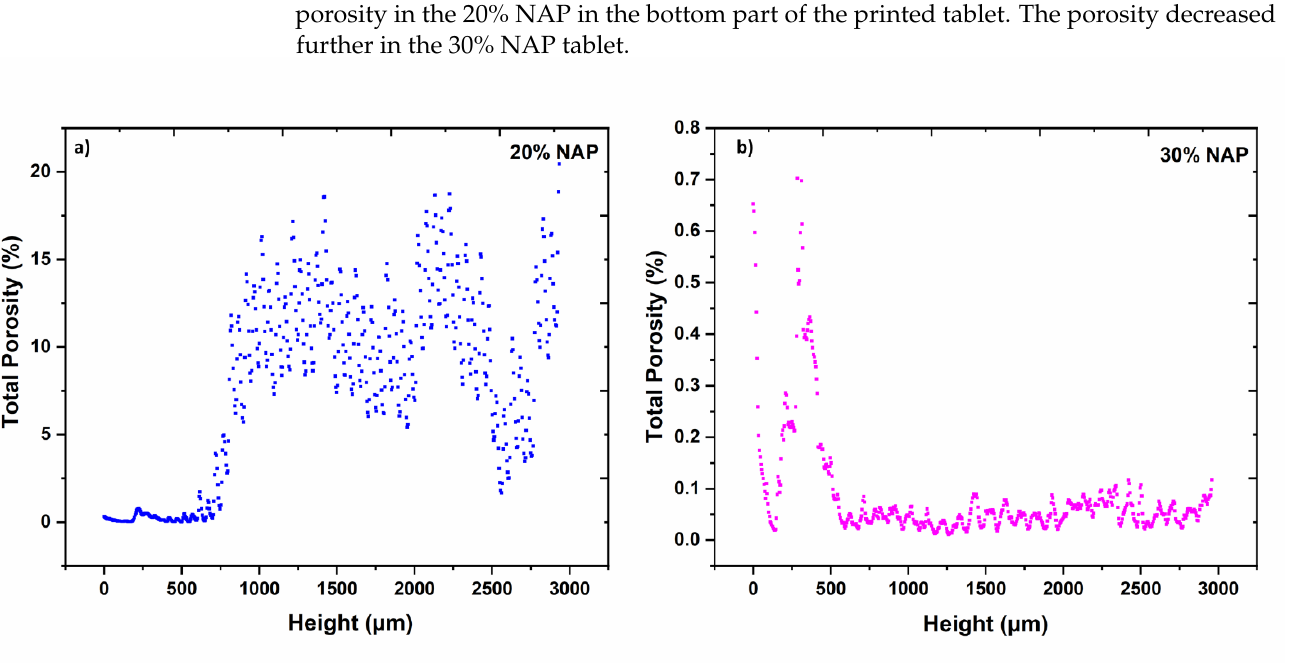
Figure 5. 2D porosity of 3D-printed tablets containing ( a ) 20% NAP and ( b ) 30% NAP.